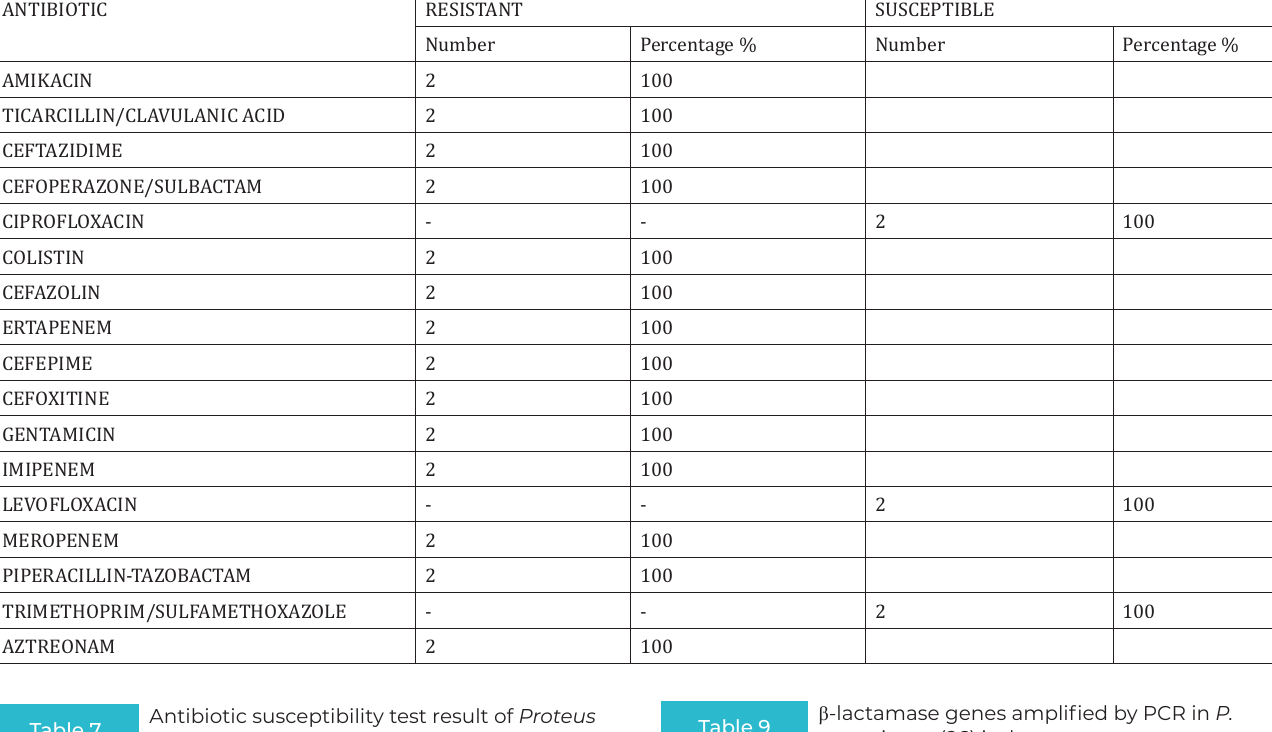
Antibiotic susceptibility test result of Chryseobacterium indologenes isolates